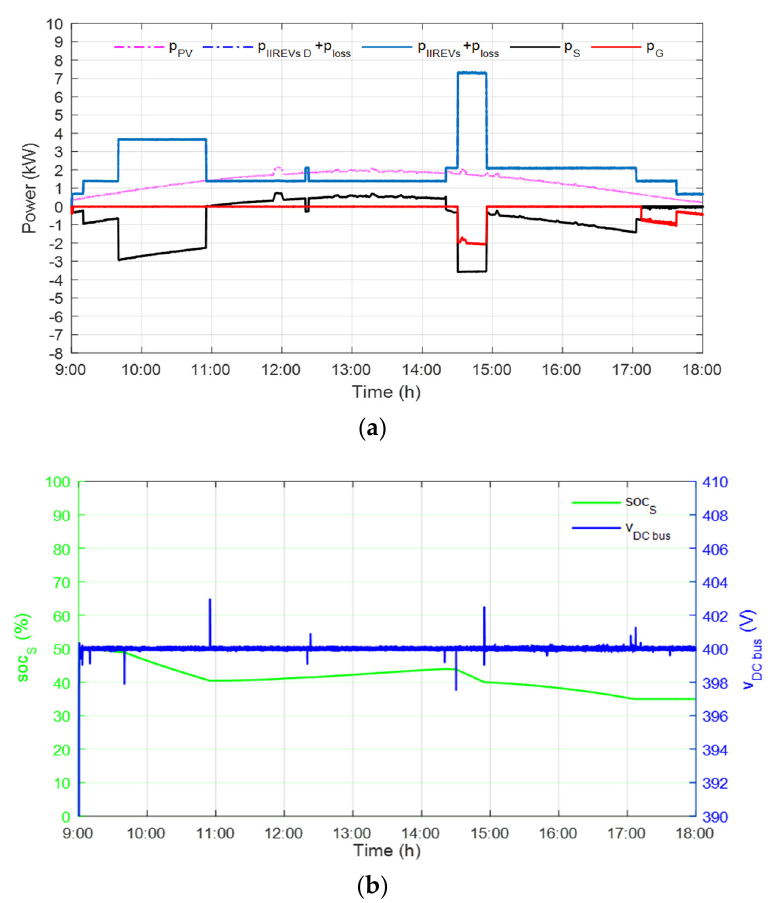
Figure 21. Power flow and storage state of charge for “real-time exp” without optimization (a) and (b) storage state of charge and DC bus voltage—experimental test 1b.